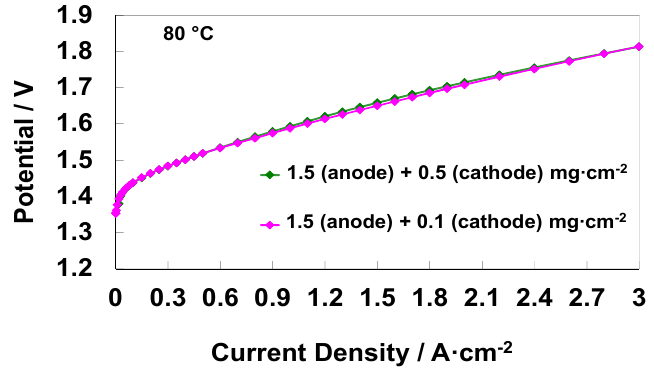
Figure 2. Comparison of the water electrolysis polarization curves for different cathode catalyst loading-based MEAs at 80 °C.